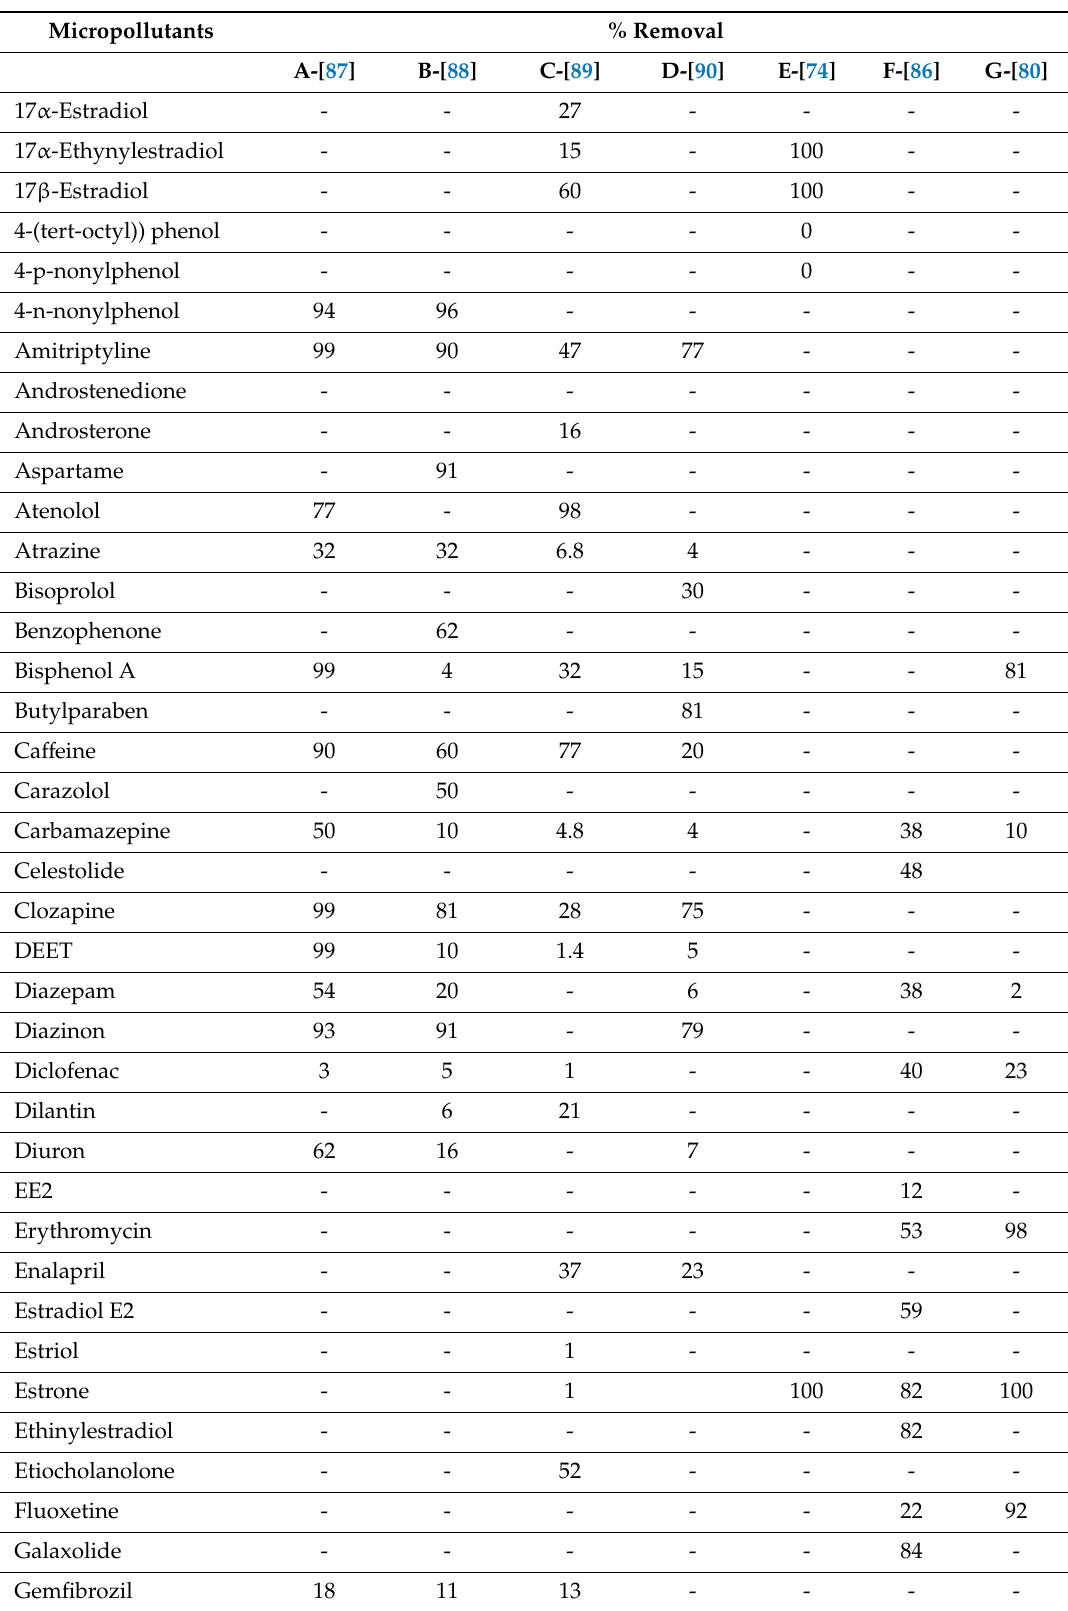
Table 3. OMP removal in AnMBR and major operating